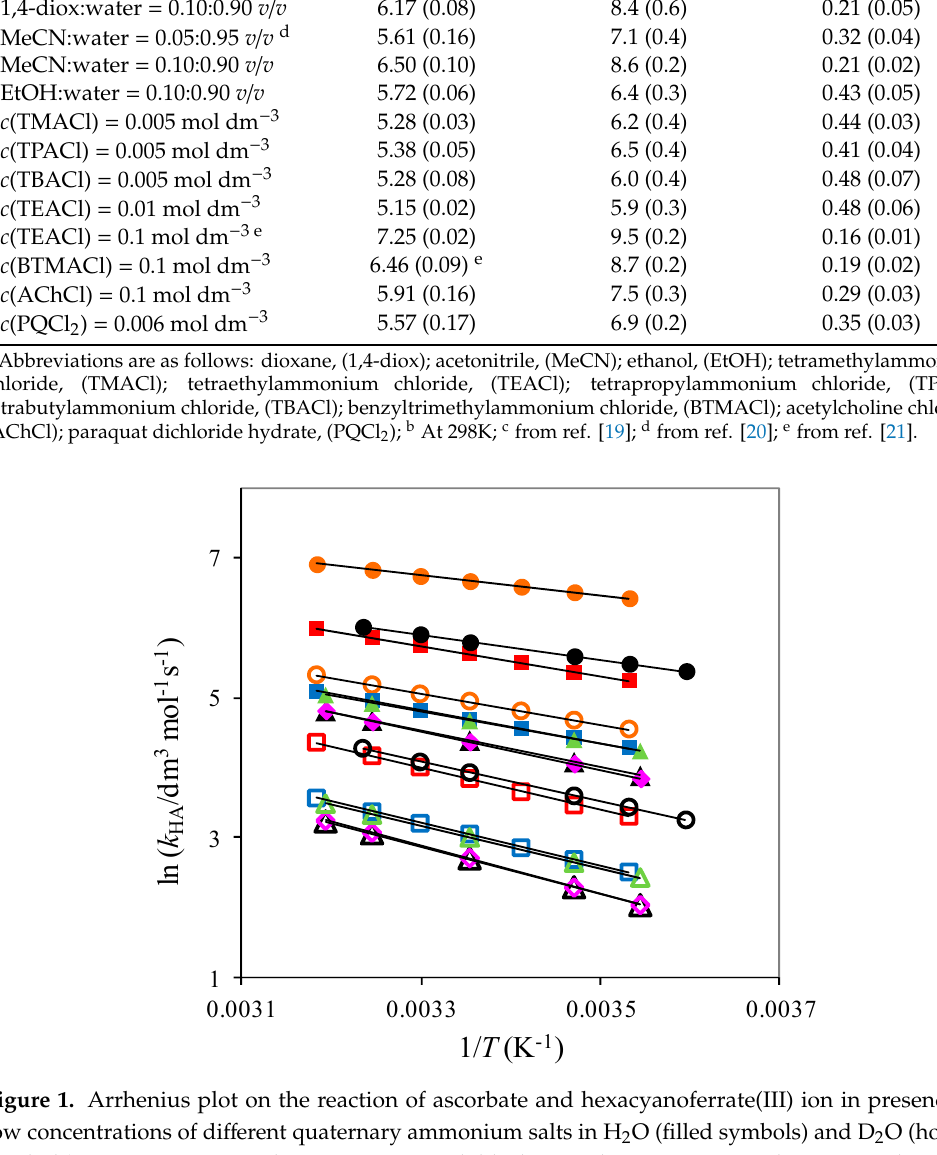
Table 1. Kinetic Isotope E ff ects, Isotopic Di ff erences ∆∆ H ‡ (D,H) and Ratios A H / A D in the Reaction of Ascorbate with Hexacyanoferrate(III) Ions (Scheme 1).